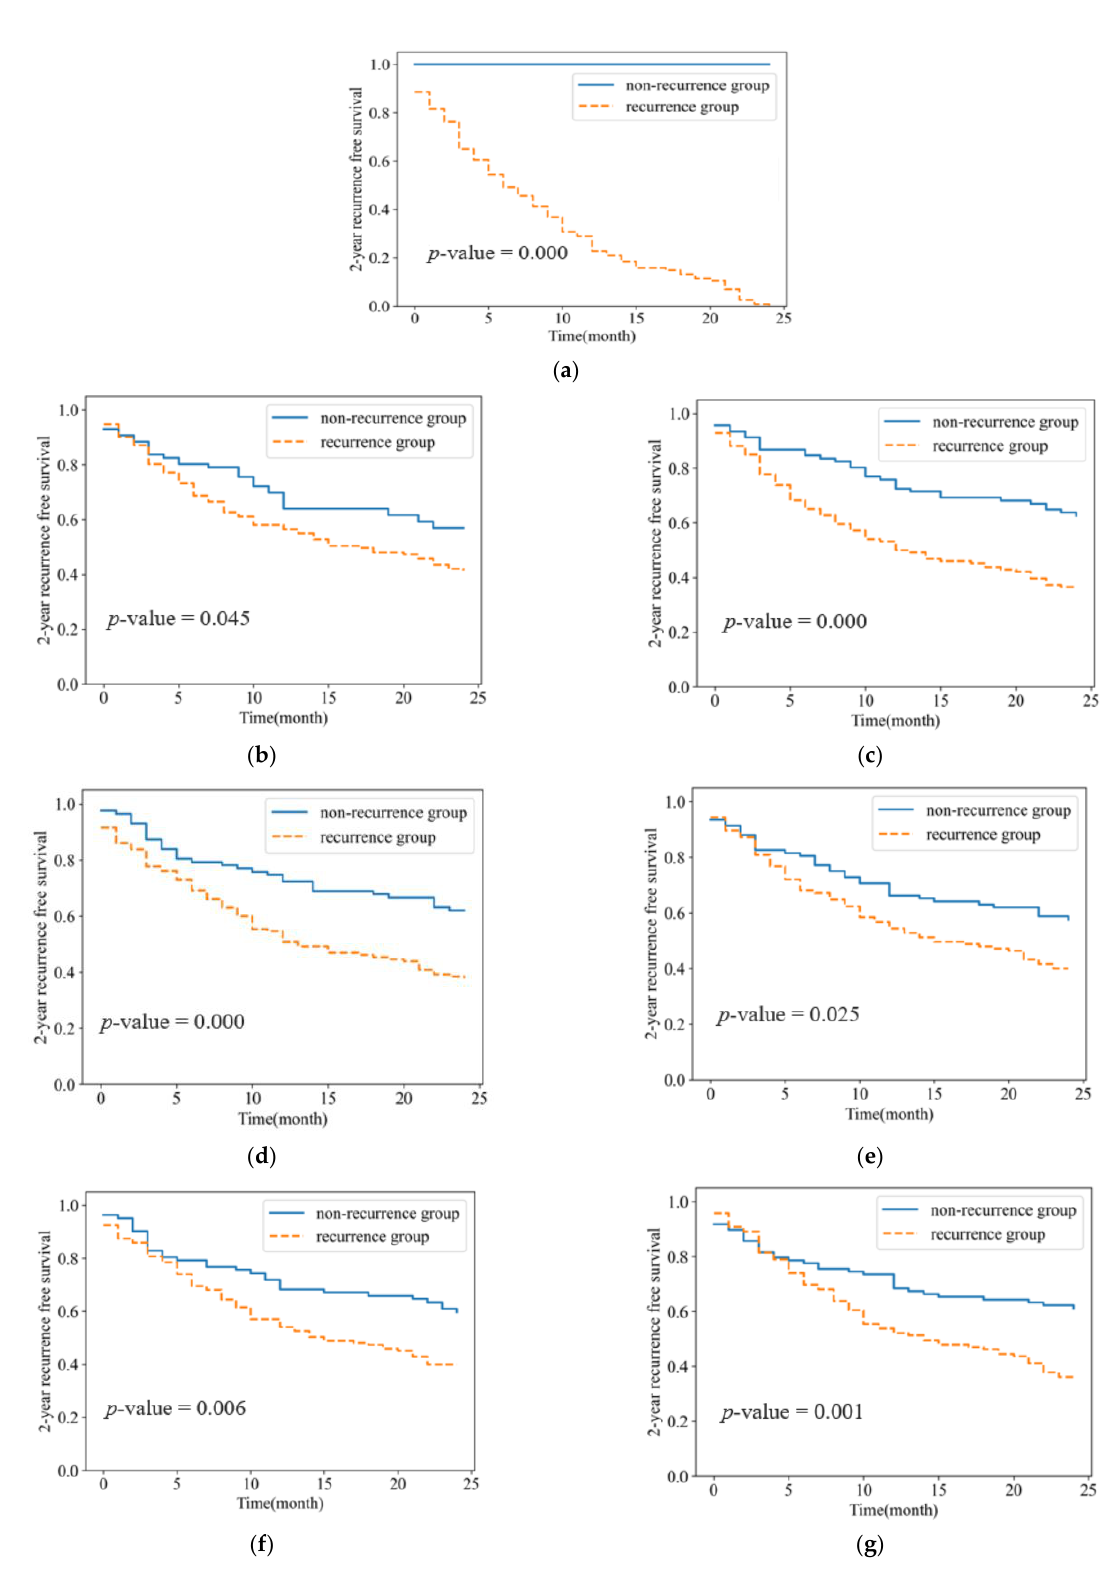
Figure 6. Kaplan – Meier curves for 2-year recurrence-free survival: ( a ) Real curve; ( b ) T stage and N stage; ( c ) Intratumoral radiomic classifier; ( d ) Peritumoral 3 mm radiomic classifier; ( e ) Peritumoral 12 mm radiomic classifier; ( f ) Combined 6 mm radiomic classifier; ( g ) Combined 9 mm radiomic